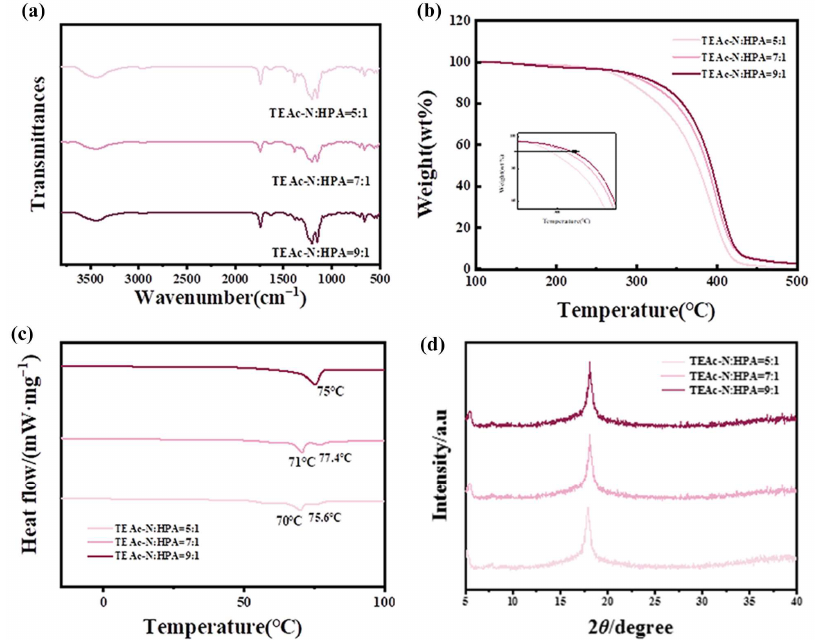
Figure 4. ( a ) FTIR spectra of different ratios of FC; ( b ) DCS of FC; ( c ) TG of FC; ( d ) XRD of FC.